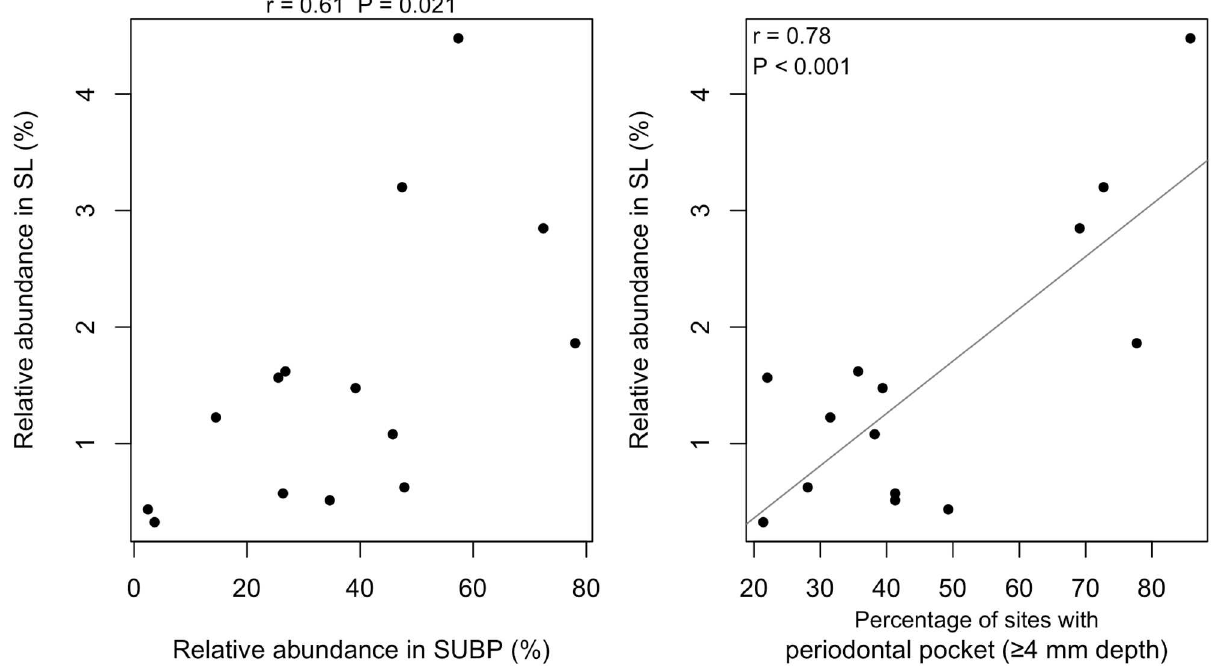
Fig 3. Correlation of the total relative abundance of the 12 SUBP-specific OTUs in SL and SUBP samples, or the percentage of sites with periodontal pockets ( (cid:21) 4 mm depth). The Pearson correlationcoefficient (r) and the P value are shown in the upper or upper left side of the diagram. The gray line depicts the regressionline.